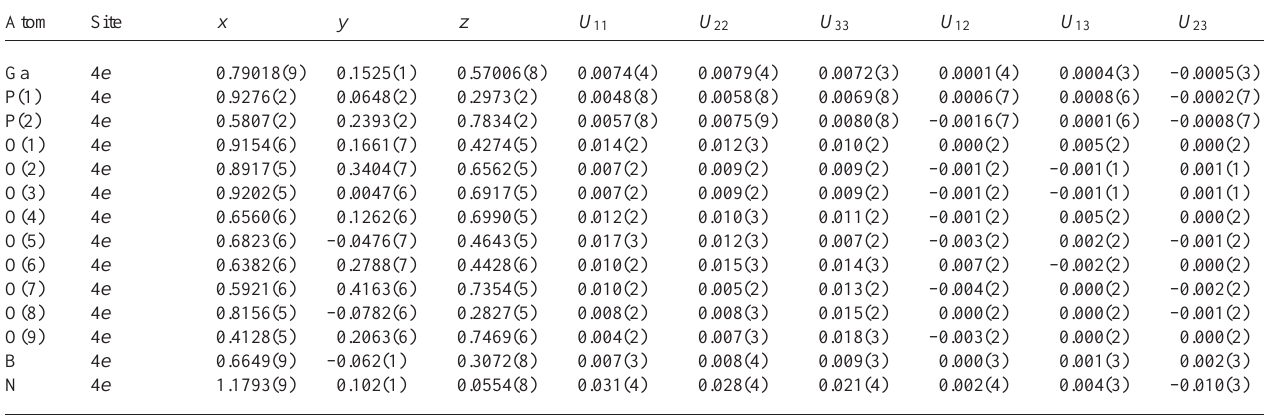
Table 3. Atomic coordinates and displacement parameters (in Å 2 )